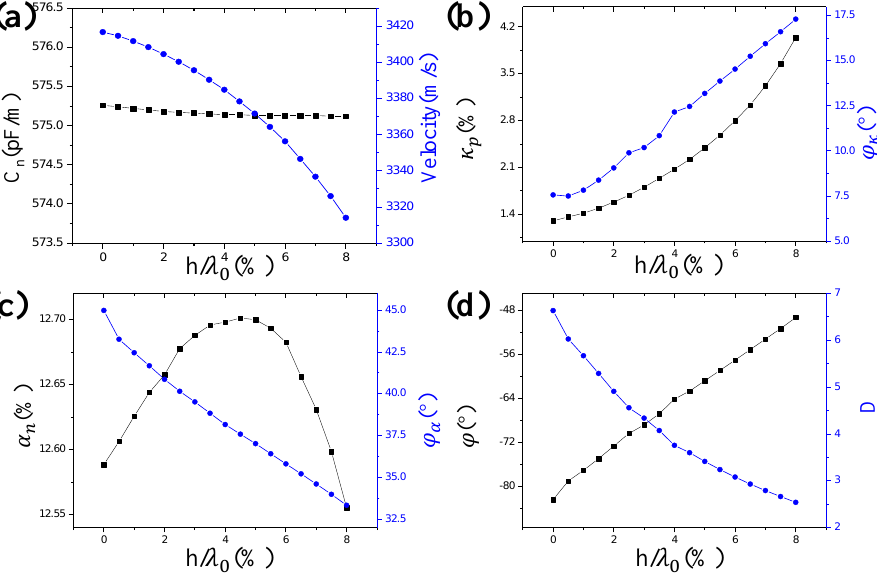
Figure 8. COM parameters versus thickness of electrode for EWC SPUDT on YZ-LiNbO 3 : ( a ) Normalized capacitance and velocity; ( b ) Reflection coefficient and its phase; ( c ) Normalized transduction coefficient and its phase; ( d ) The unidirectional angle and directivity.